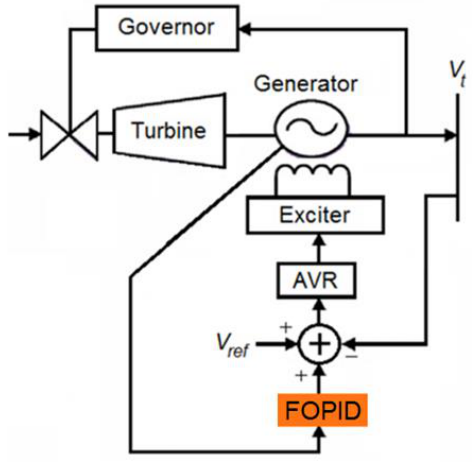
Figure 5. The simple structure of the SG control system with the FOPID controller.